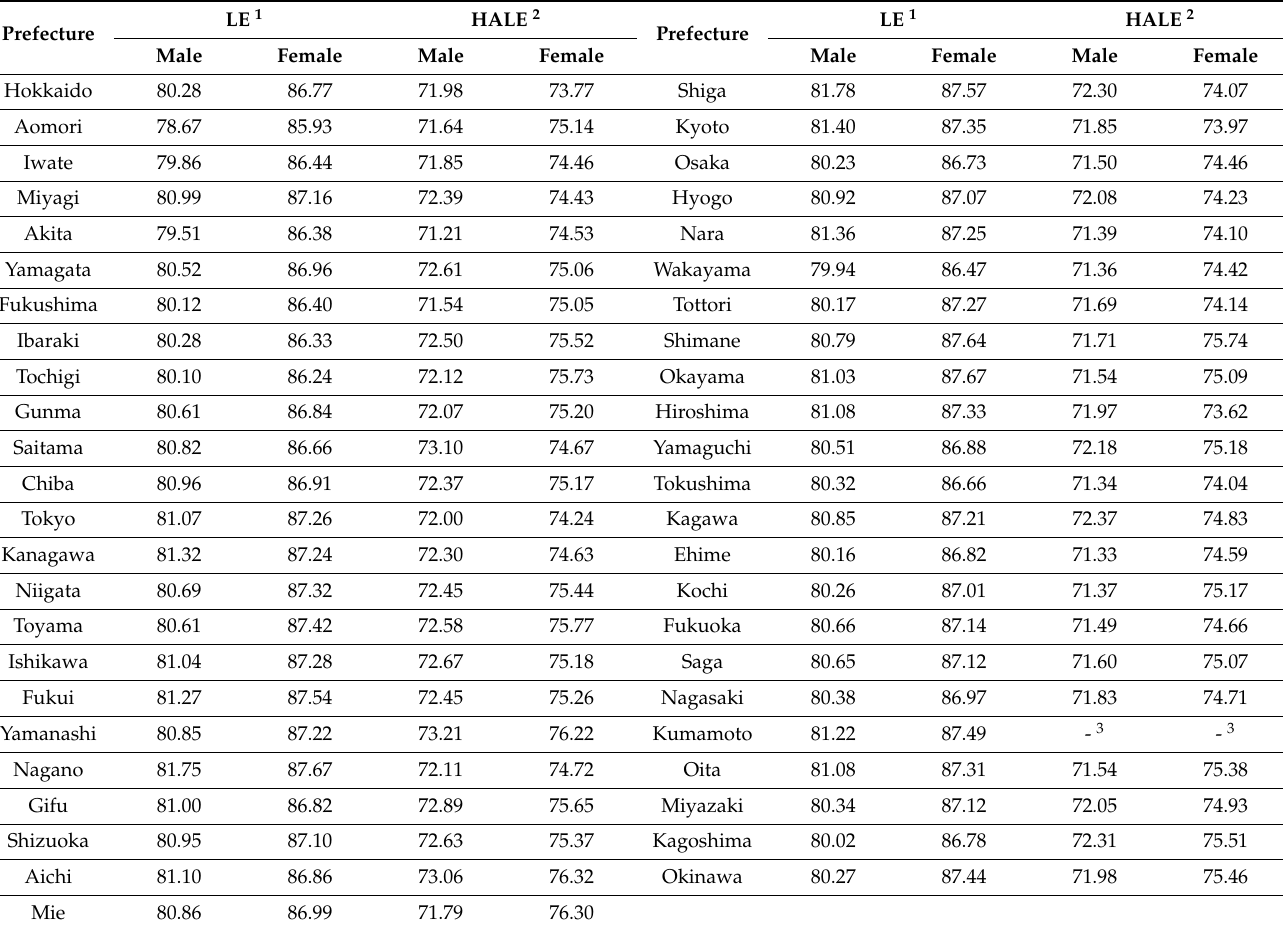
Table 3. Summary population variables (LE and HALE by prefecture and gender).